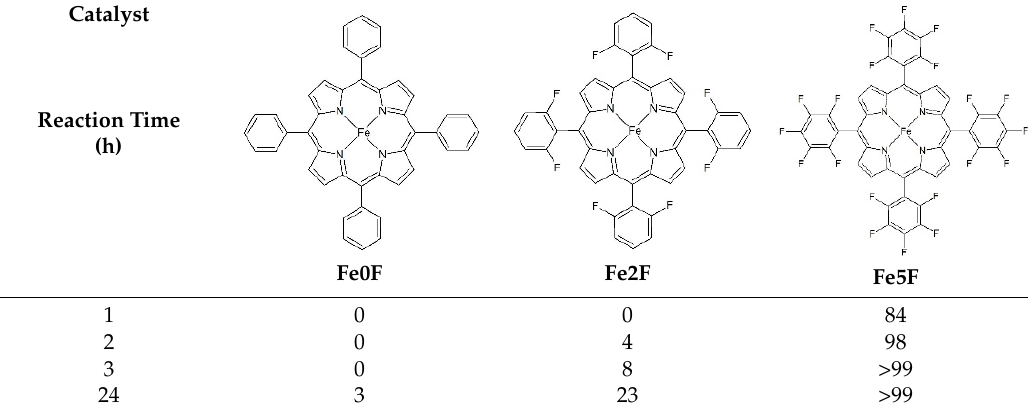
Table 1. Conversion (%) in the synthesis of 2a catalyzed by Fe0F , Fe2F , and Fe5F at different times. 1 Catalyst